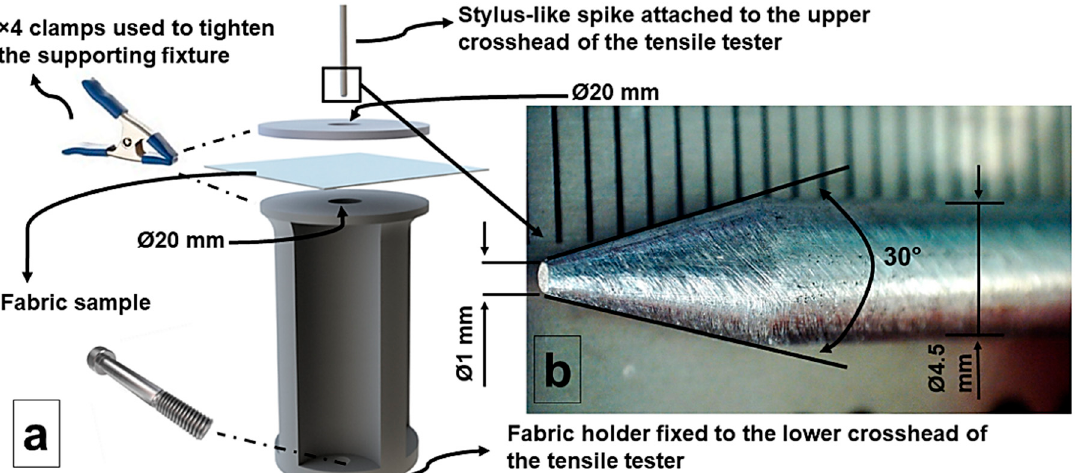
Figure 1. ( a ) Schematic of penetration test setup. ( b ) Stylus-like spike, according to EN 388:2016 standard (millimeter-scale).